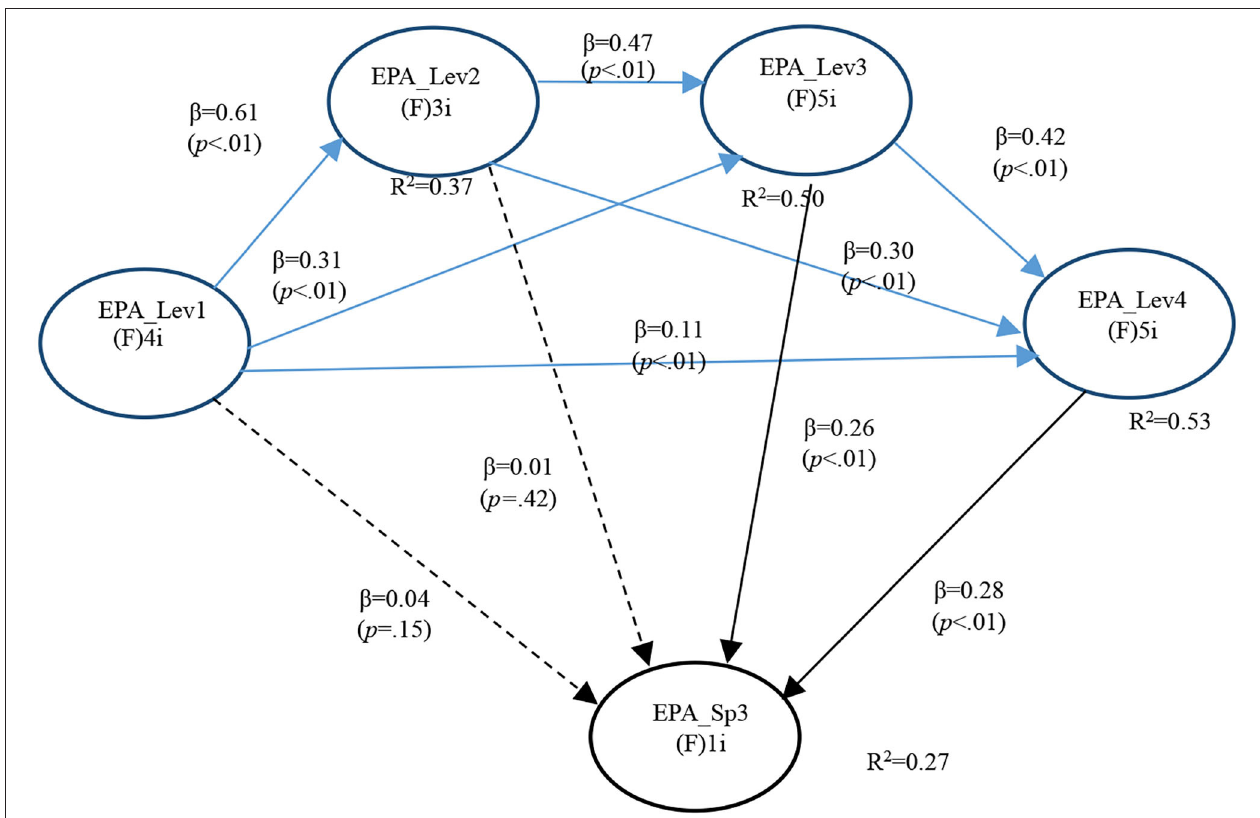
FIGURE 3 | Full model for GI EPA 3.